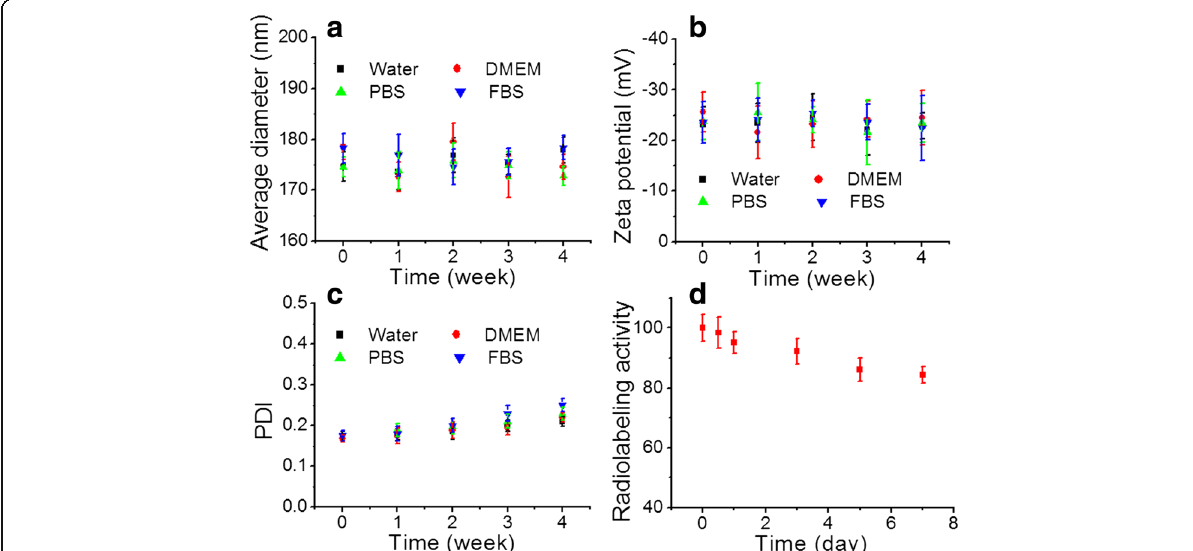
Fig. 3 a , b Colloid stability and c PDI test of FA-PLP- 131 I in different media, including water, DMEM, PBS, and fetal bovine serum (FBS). d Radiolabeling stability curve of FA-PLP- 131 I in mouse plasma at 37 °C within 2 weeks of